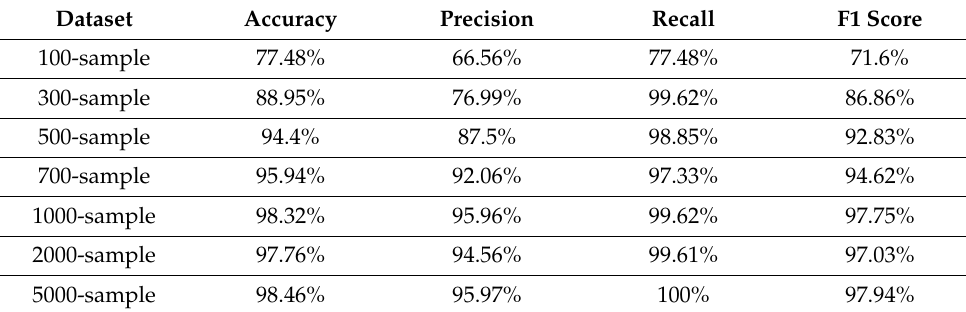
Table 4. A summary of the performance of each model.